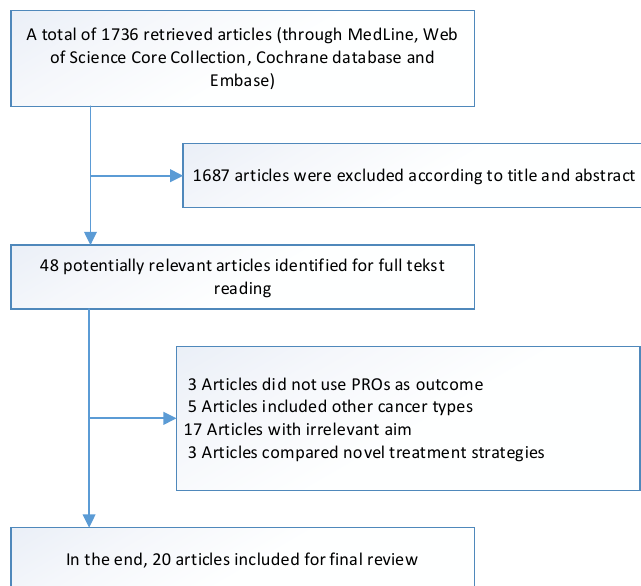
Figure 1. Flow diagram of relevant article selection.